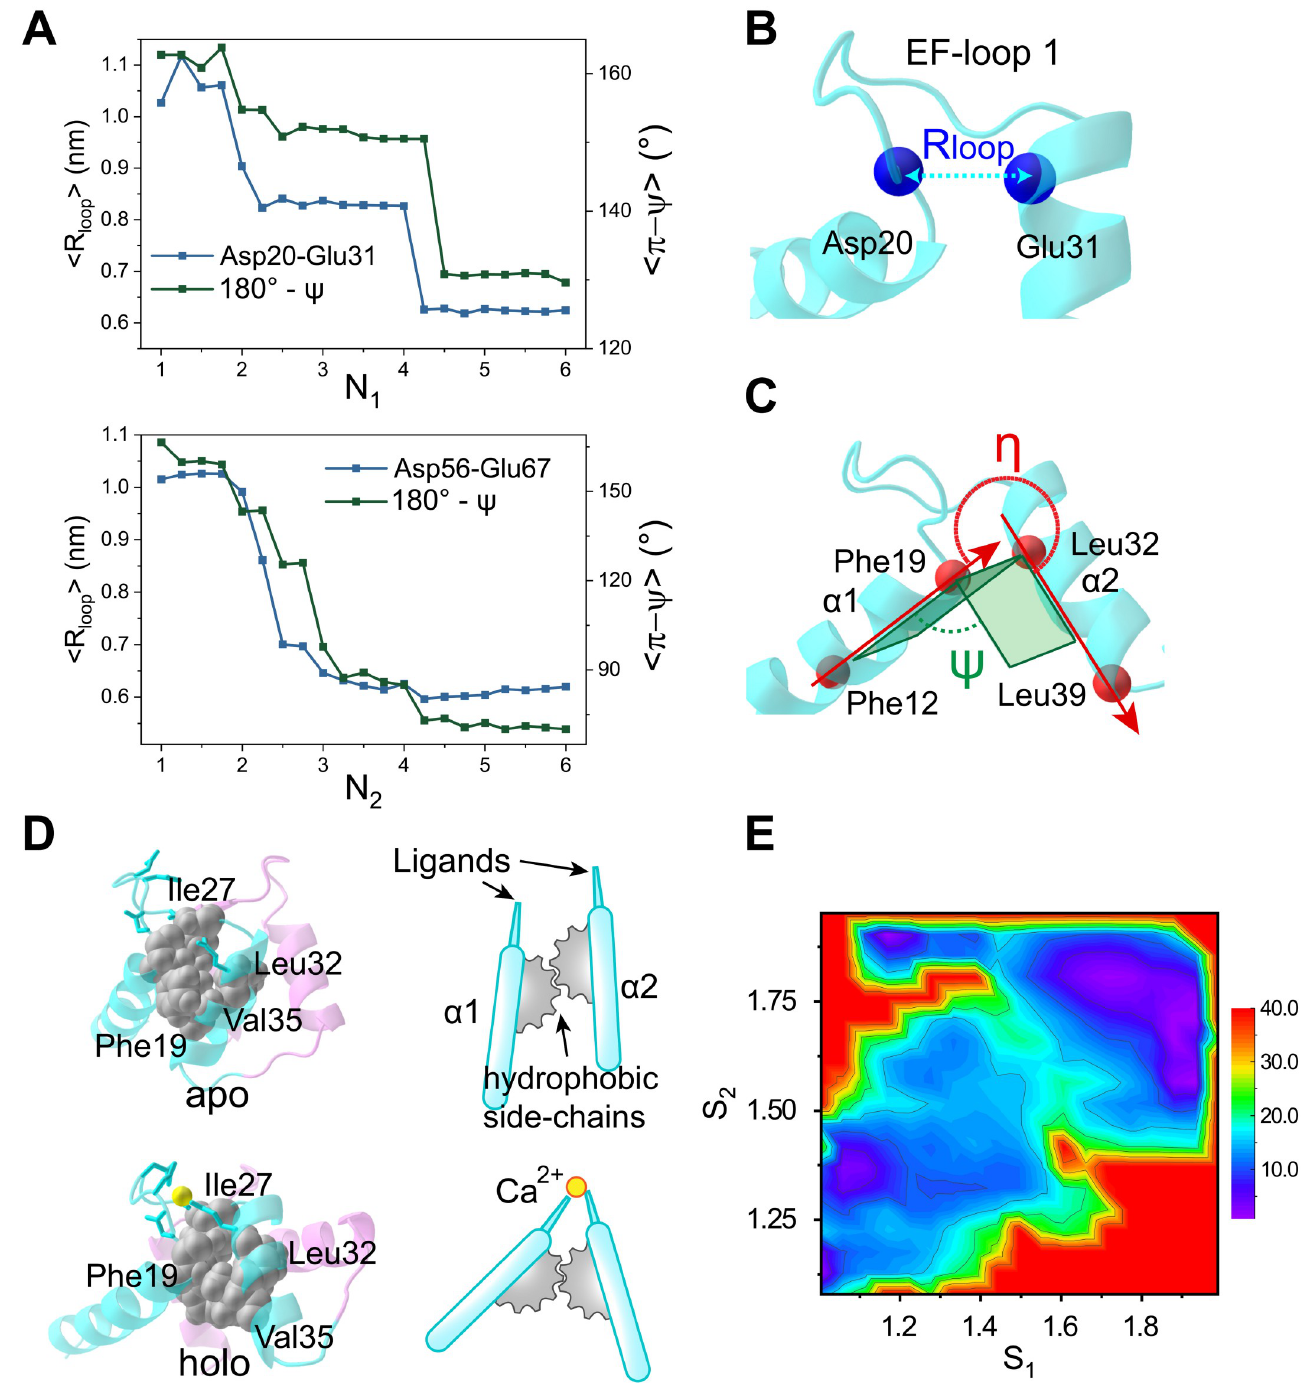
Fig 5. Ca 2+ binding induced rotation of EF-hand helices. (A) The distance between close ends of EF-loop 1 (represented by the C α atoms from Asp20 and Glu31) and the dihedral angle characterizing the rotation of the two helices of EF 1 as a function of N 1 (upper panel). The same results for the EF 2 are shown in the lower panel of (A). (B) Schematic diagrams illustrating the end-end distance of EF-loop1 and (C) the inter-helical angle and diheral angle of EF 1 . The end-end distance of EF-loop is represented by the distance between C α atoms: EF-loop1 by Asp20–Glu31, and EF-loop2 by Asp56–Glu67. The direction of helices are represented by vectors pointing from one residue’s C α atom to another residue’s C α atom: α 1 by Phe12–Phe19, α 2 by Glu31–Leu39, α 3 by Leu48–Val55, and α 4 by Phe68–Lys75. The dihedral angles C are defined by the C α atoms of the residues Phe12–Phe19–Glu31–Leu39 for EF 1 and Leu48–Val55–Phe68–Lys75 for EF 2 . (D) Schematic diagram of the Ca 2+ binding induced EF-hand helix rotation. Black spheres indicate the hydrophobic core in EF 1 . (E) Free energy profile of nCaM conformational transition projected onto S 1 and S 2 . The free energy scale is in